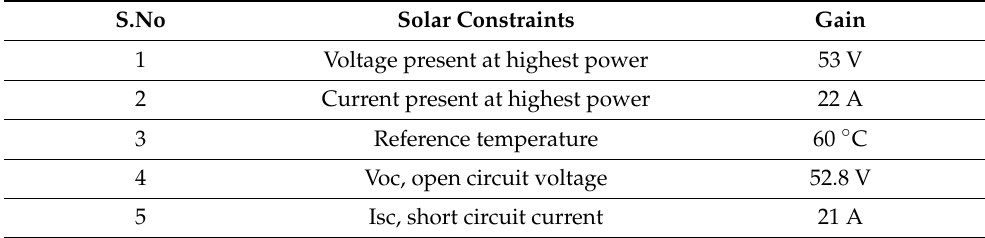
Table 1. Major electrical constraints of the solar